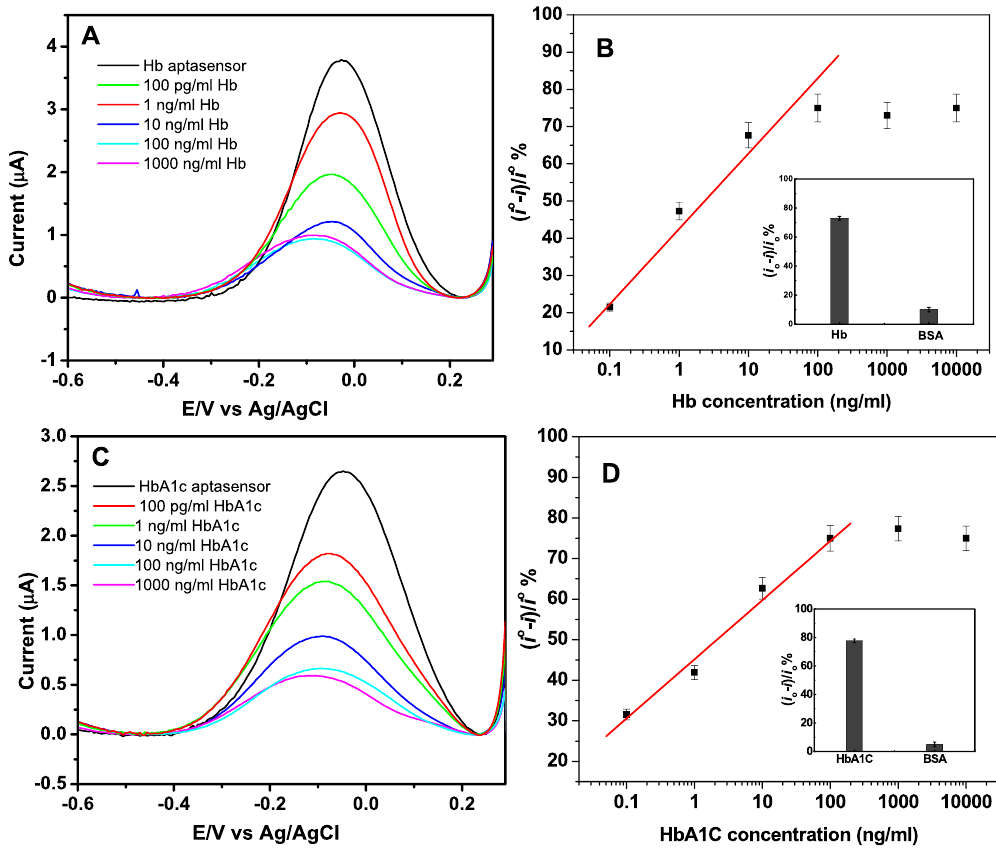
Figure 5. SWVs of the aptasensors before and after binding with different concentrations of Hb ( A ) and HbA1c ( C ), Calibration curves for Hb ( B ) and HbA1c ( D ). Insets are the specificity studies of the aptasensors against